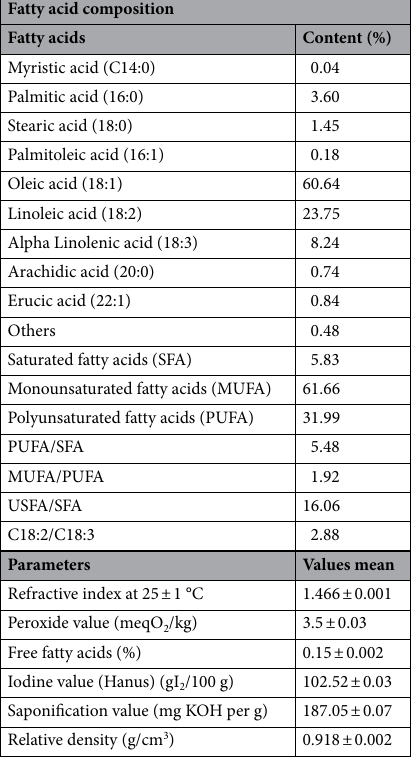
Table 2. Fatty acid composition and physicochemical characteristics of canola